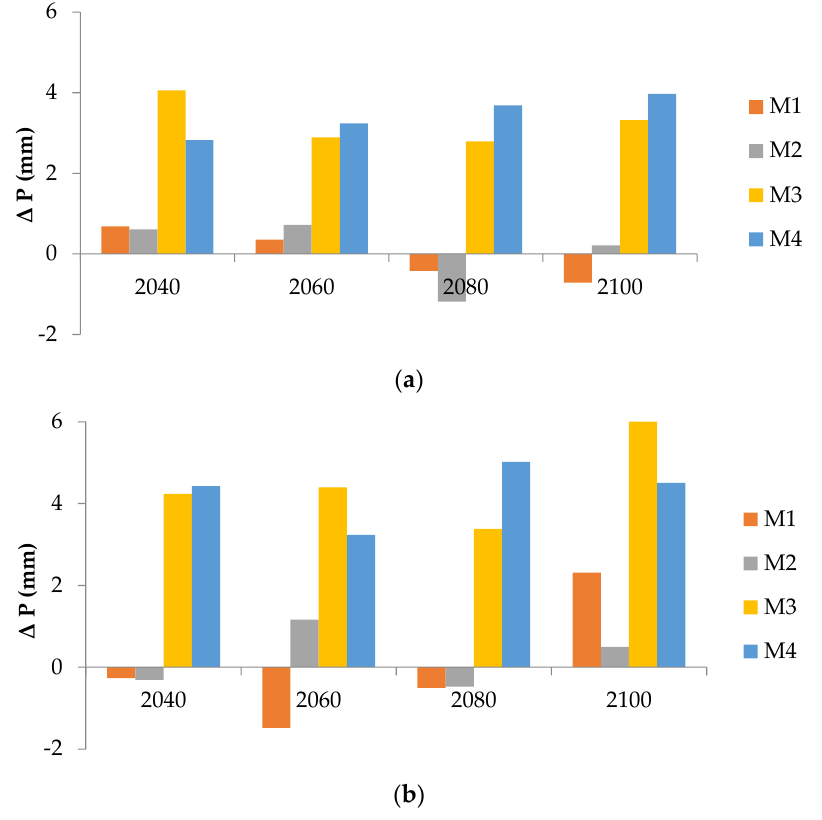
Figure 11. Δ Rainfall values for the four climate models under ( a ) SSP2-4.5 and ( b ) SSP5-8.5. The Tmin and Tmax indicated an increasing trend for both scenarios. The results show a current mean Tmin range of 6.5 °C (in January) to 24.4 °C (in August) with an average of 16.5 °C and show a Tmax range of 18.4 °C (in January) to 41.4 °C (in July) with an average of 31.4 °C.